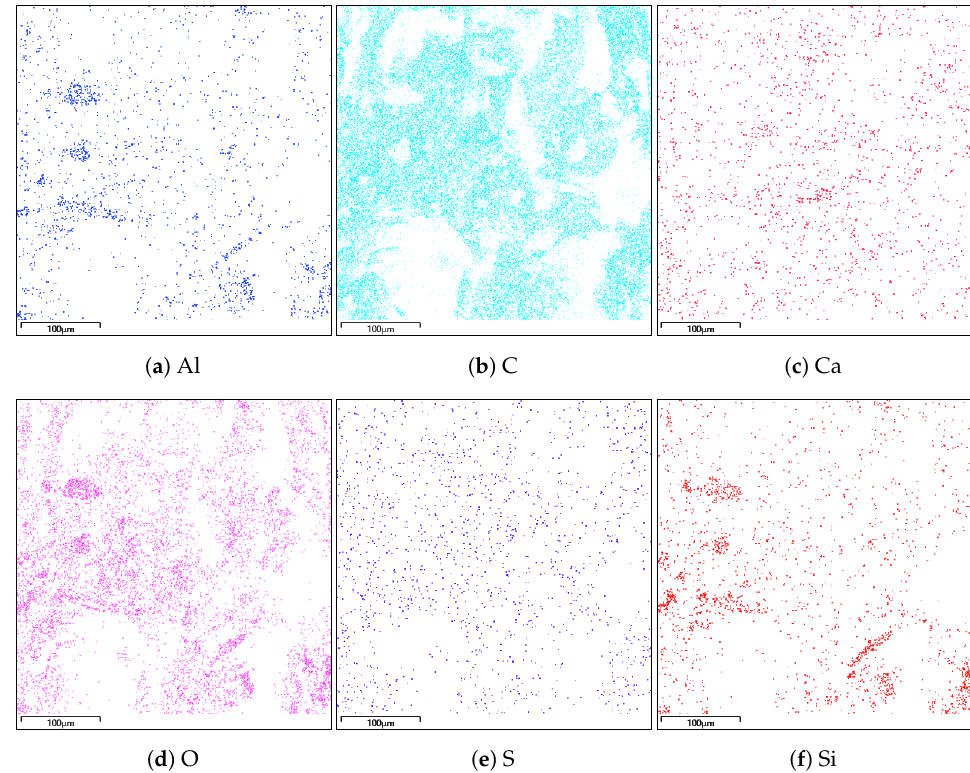
Figure 16. Distribution of individual chemical elements on the cross-sectional area in the material